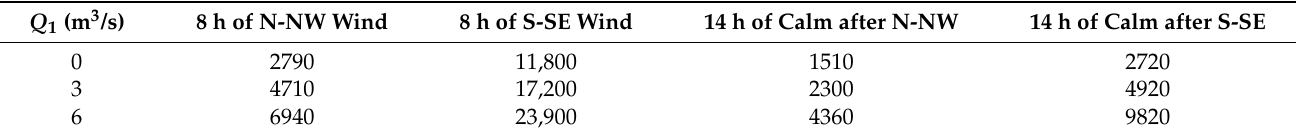
Figure 12. Instant flux of suspended particulate matter to EB (kg/s), for a wind speed of 15 m/s and for Q 1 equal to 0, 3 and 6 m 3 /s, during the imposed wind regimes: ( a ) N-NW wind; ( b ) S-SE wind. The total flux to EB of the six SPM classes, for the windy and calm periods separately, is given in Table 4, for the three values of Q 1 , for the wind speed of 15 m/s. Table 4. Total SPM flux (kg) to EB for each scenario of 24 h for wind and calm